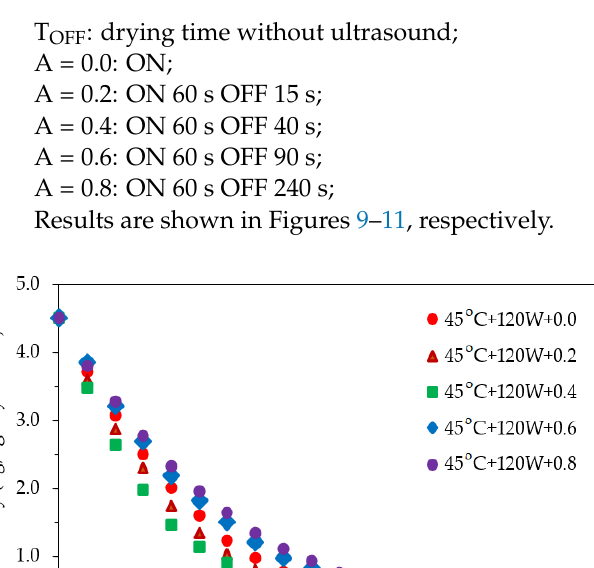
Figure 11. Effect of intermittent drying on saponin content. Figure 12a is the result of heat pump drying at 45 °C, while Figure 12b–f is the results of ultrasound-assisted drying with different intermittency ratios (A). Ultrasonic wave propagation helps to create microchannels and break the moist boundary layer of the material. Based on the obtained SEM images with a magnification of 200 times, it is observed that the material surface with ultrasound-assisted drying is porous, while heat pump drying results in an almost non-porous material (Figure 12a). This porous property stimulates the process of moisture transfer, thereby shortening the drying time. Notably, it is observed that the density and size of pores depend on the intermittency ratio. With intermittency ratio A = 0.2 (Figure 12e), the greatest number of pores and the largest pore size can be observed compared to those of other intermittency ratios. Thus, this drying mode A = 0.2 results in the shortest drying time with the best value of moisture diffusion coefficient Deff. Drying temperature has a strong effect on the color and saponin content of the product. By adjusting the drying time, we can minimize the exposure of ginseng to heat, and ultrasound-assisted intermittent drying helps to improve color and retain as much saponin content with an appropriate intermittency ratio. Ultrasonic wave propagation increases the temperature of the material due to mechanical vibration [6]. The temperature rise caused by ultrasonic waves in the air ranges from 1 to 10 °C, depending on specific drying conditions. During intermittency (T OFF ), the thermal effect caused by energy transfer of ultrasound in the material is OFF, thereby limiting the color change and retaining as much saponin content.